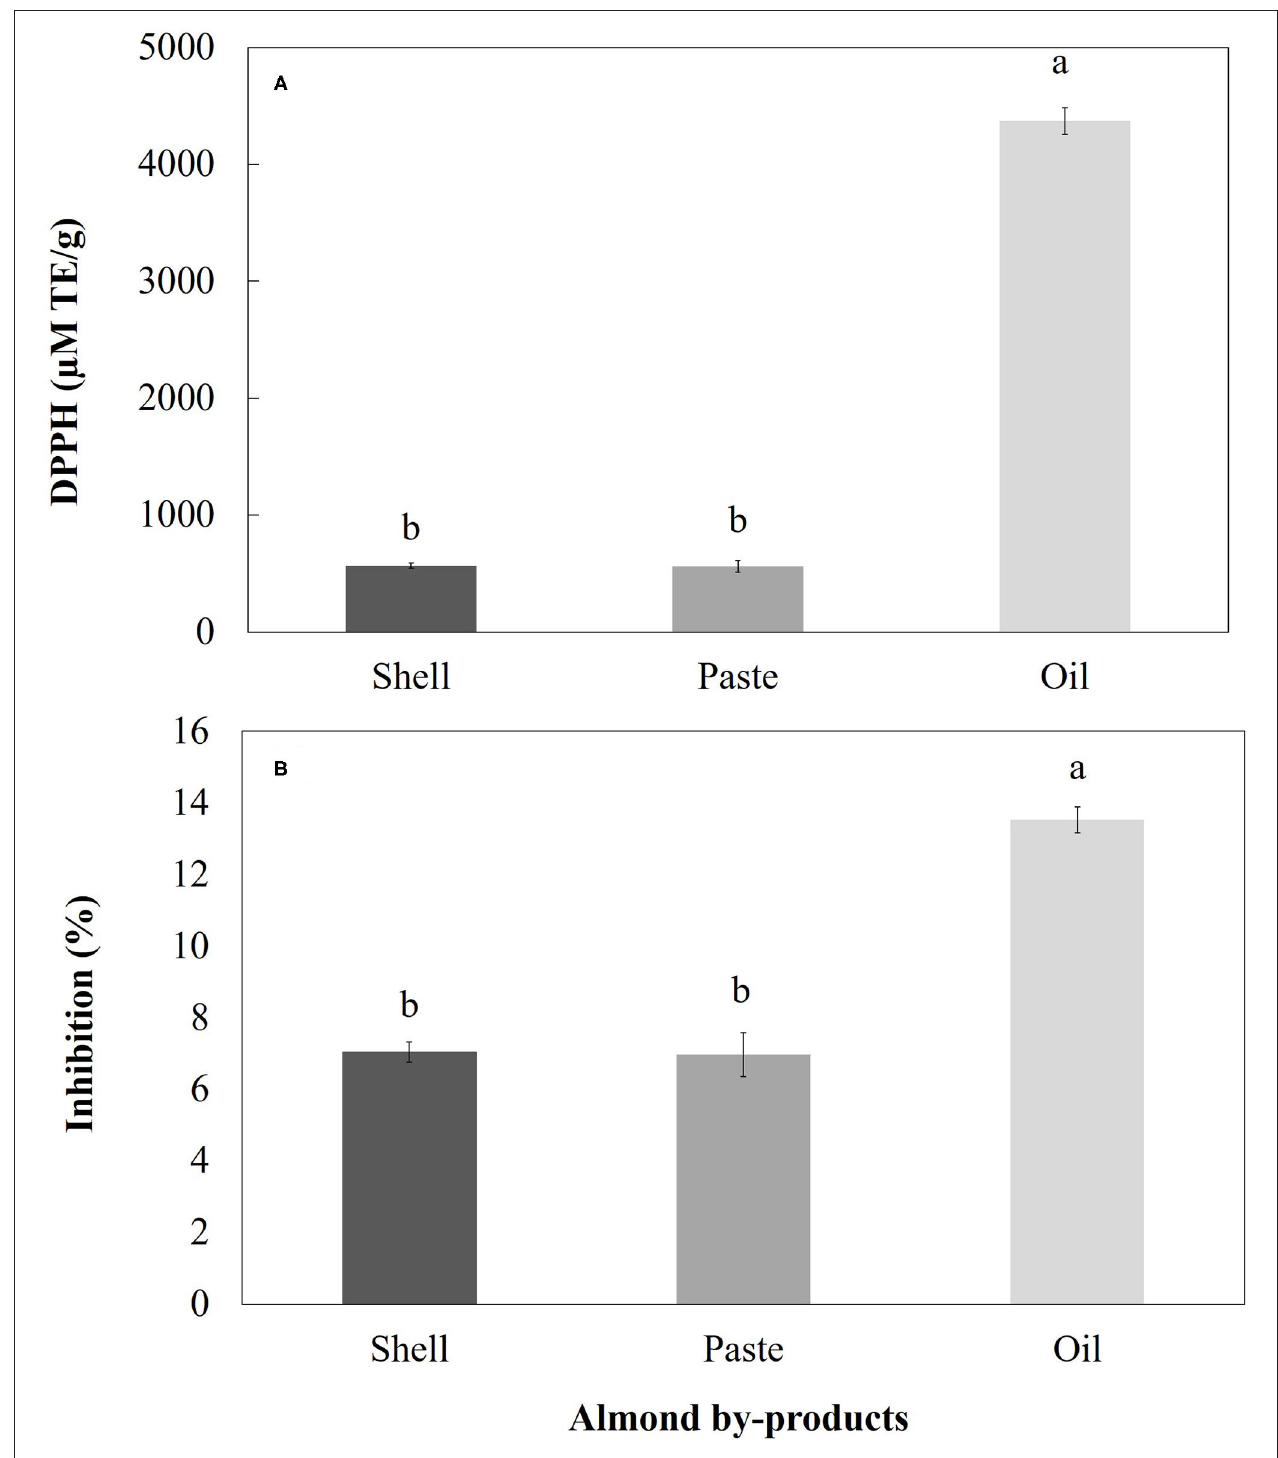
FIGURE 6 | (A) Antioxidant activity and (B) DPPH radical scavenging activity of various almond by-products extracted with ethanol. The vertical bars indicate mean ± standard deviation ( n =